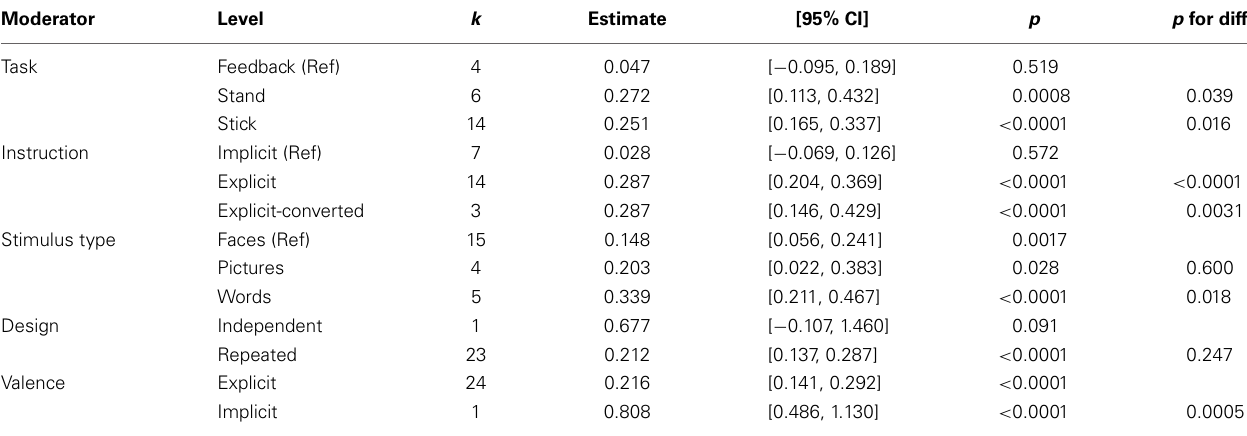
Table 1 | Results of moderator analyses of positive